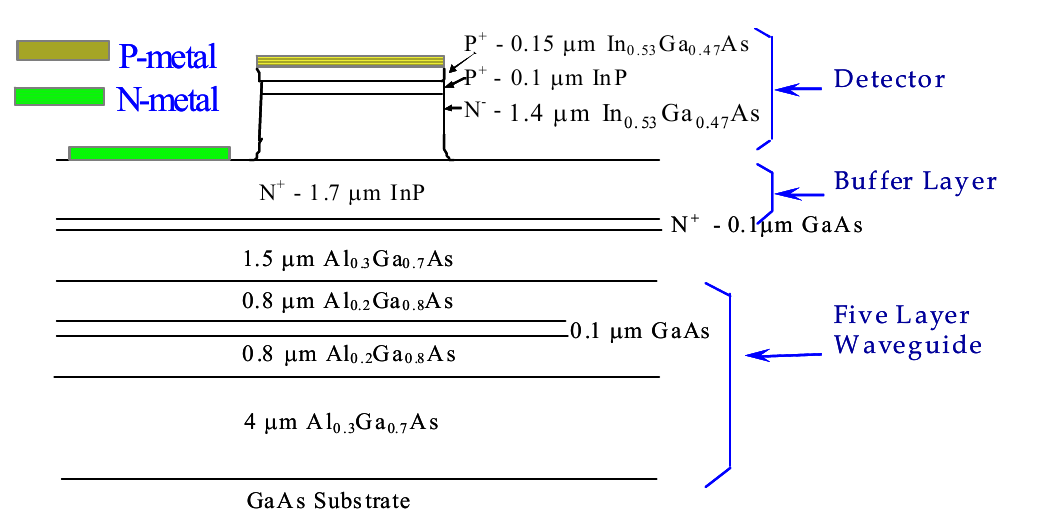
Ga As/InP double 0.53 0.47